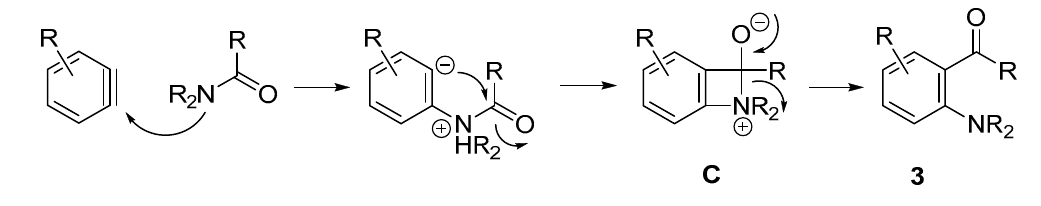
Scheme 2. Activation of amide N–C bond by arynes.